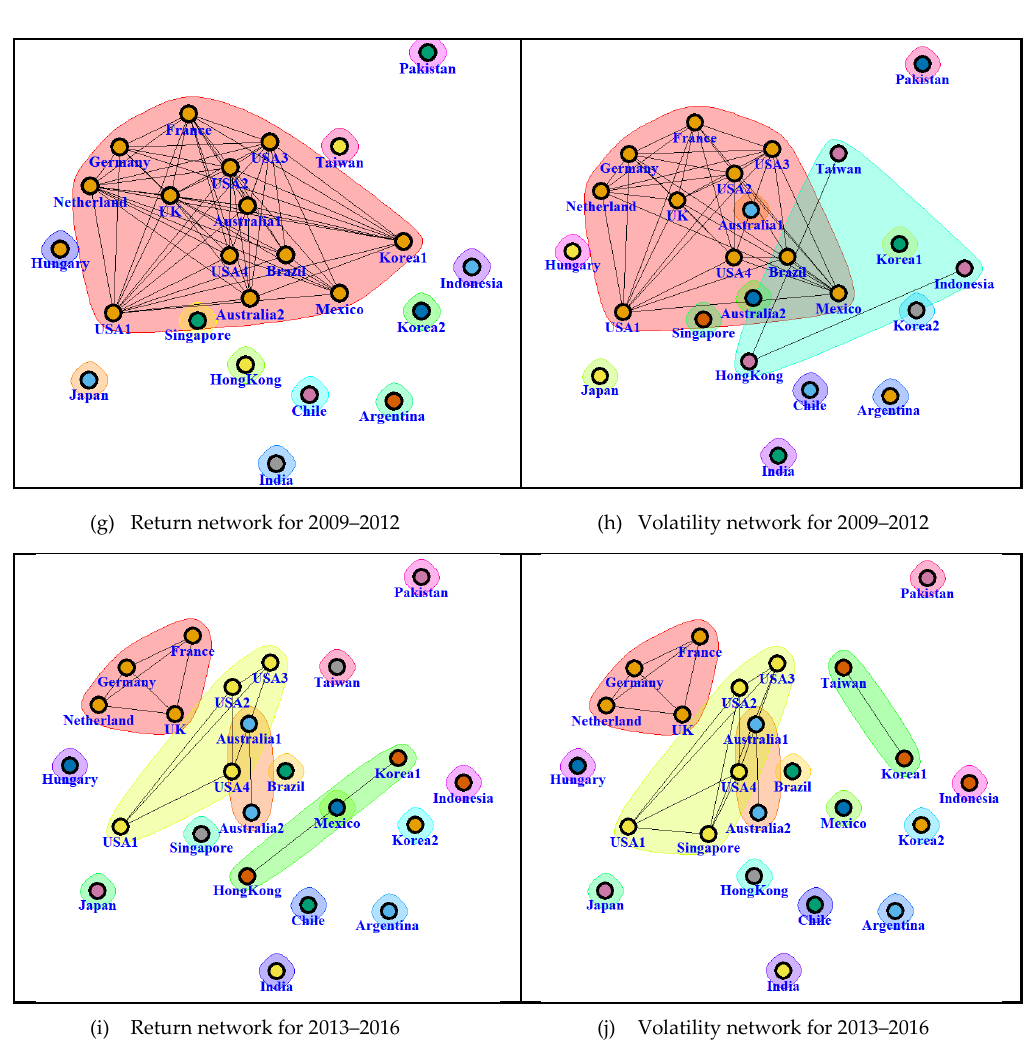
Figure 5. Community structures of return and volatility for global 24 stock markets of four-year length time series. The networks are formed by DCCA and the community structure and the communities are structured by the Girvan-Newman method . The communities are gradually larger to 2005–2008, and then they are divided into small communities.